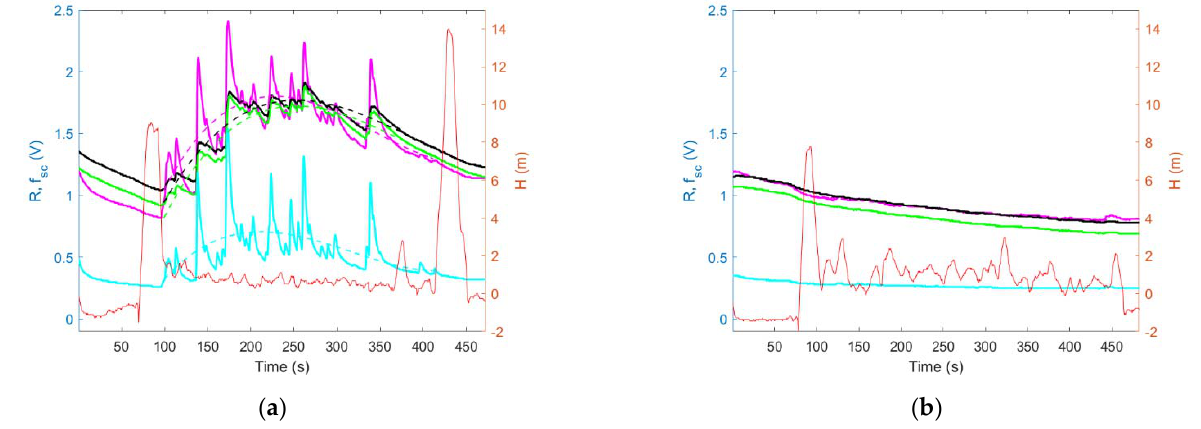
Figure 14. Results of measurements performed by the sensing drone during experiment CE2, when the sensing platform was: ( a ) lowered from the drone, ( b ) docked under the drone. Gas sensor signals are shown using solid lines: GM102B (magenta), GM302B (black), GM502B (green), and GM702B (cyan). The systematic components of sensor signals are shown using dashed lines, respectively. A solid red line indicates the sensing platform height above the ground.